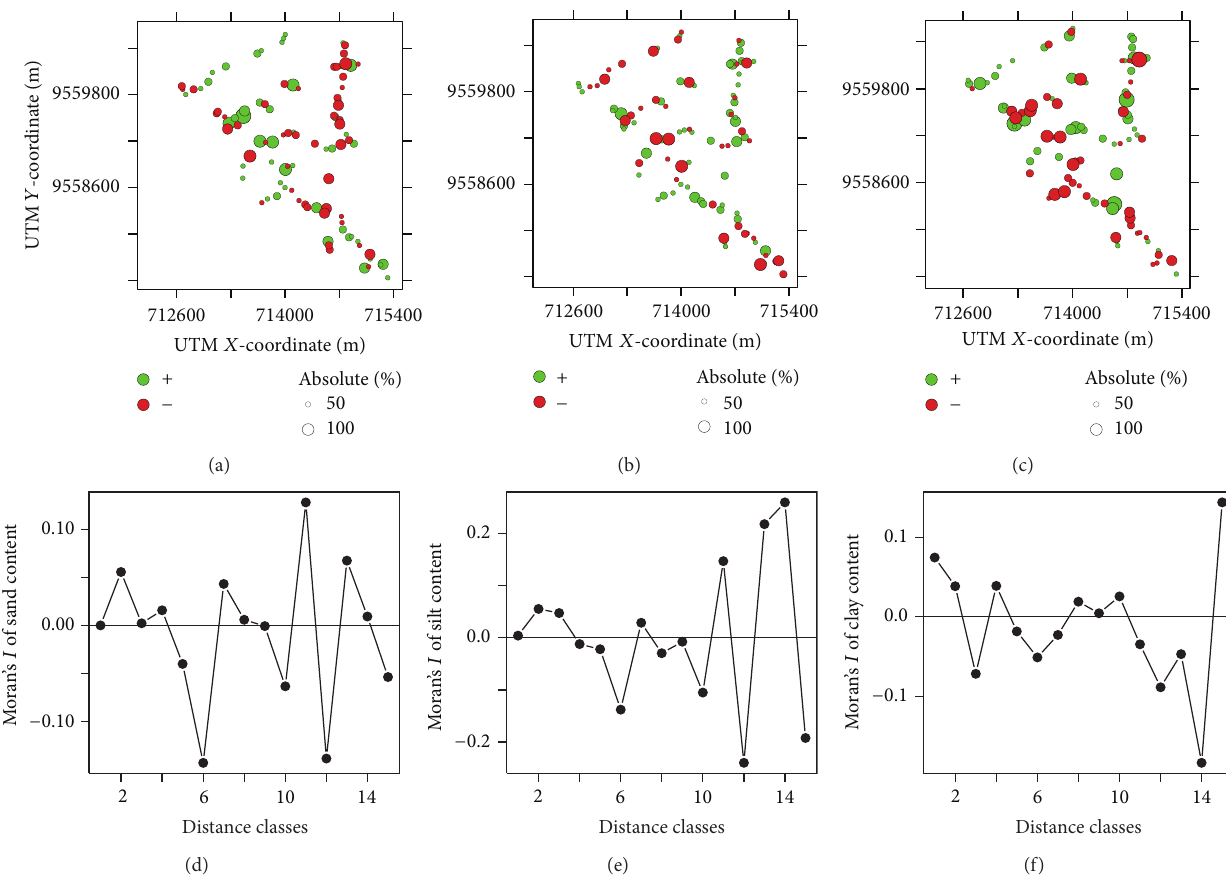
Figure 7: Spatial distribution of residuals in % of the maximum absolute residual value (red = negative values, green = positive values, top) and Moran’s 𝐼 (bottom). Models from gradient boosting for ((a) + (d)) sand content, ((b) + (e)) silt content, and ((c) + (f)) clay content.